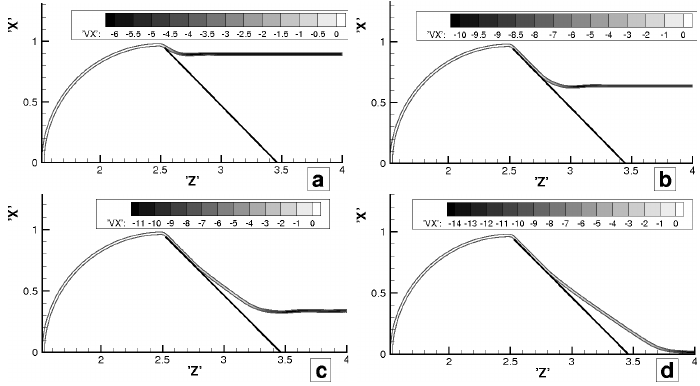
Figure 7. The thermoelastic liner positions for different times ( t = 0 . 048; 0.072; 0.105; 0.136 ms).